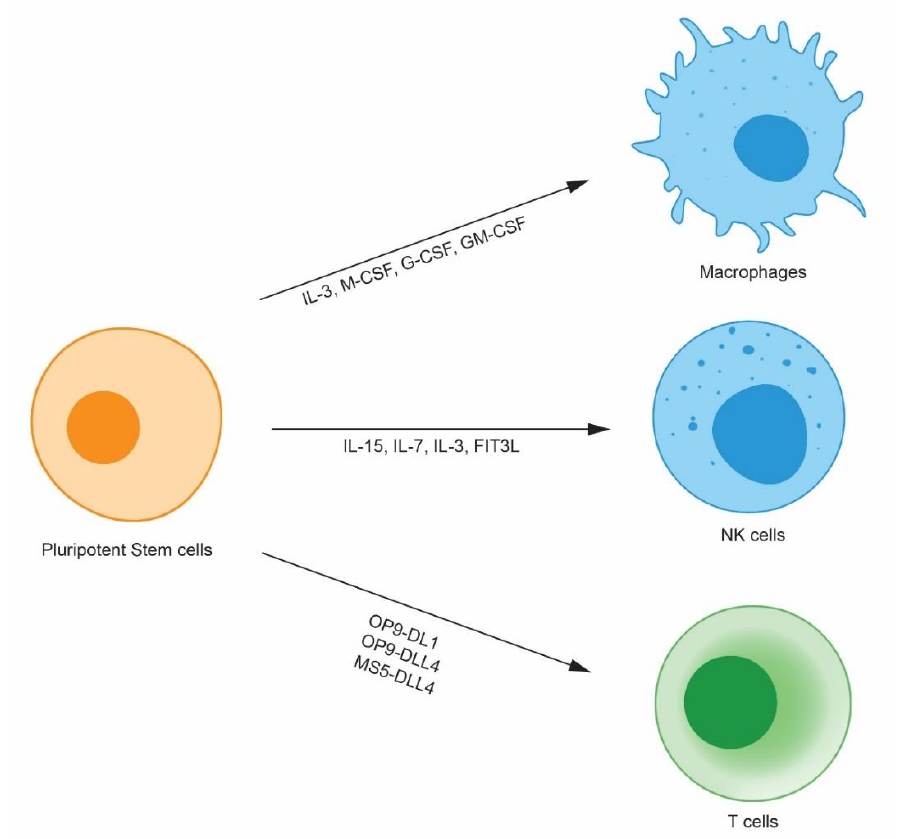
Figure 1. Human pluripotent stem cell-derived immune cells. Human pluripotent stem cells differentiate into immune cells such as macrophages, natural killer (NK) cells, and T cells by virtue of cytokines and stromal cells. Because human pluripotent stem cells proliferate indefinitely, they can be clonally selected after gene modification and can provide an unlimited number of modified immune cells.